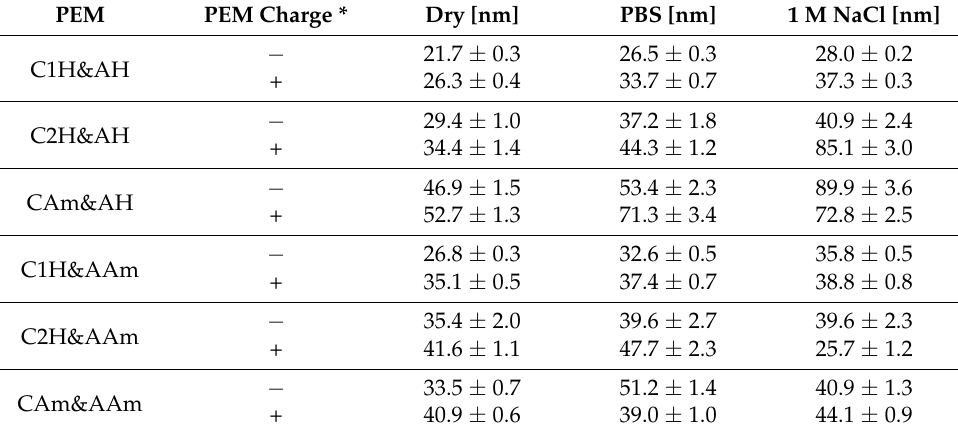
Table 3. Thickness of PEMs (14 for negatively and 15 layers for positively charged topmost layer) supported on silicon measured for dry, swollen for 30 min in phosphate-buffered saline (PBS) or 1 M NaCl solution